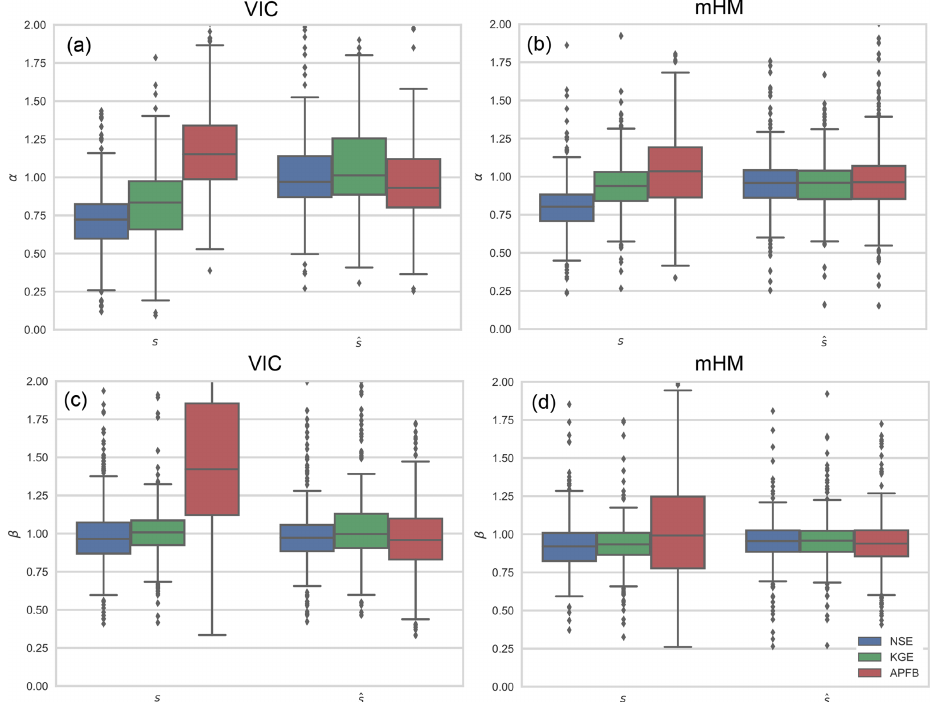
Figure 8. Distribution of the two error metrics ( a , b : α and c , d : β ) computed based on the simulations from NSE-, KGE-, and APFB- calibrated models (labeled as s). The distribution of median error metrics (labeled as ˆ s) are based on 100 residual augmented flow series. The evaluation results shown here correspond to the evaluation period. Box-plot representation is the same as Fig. 4.